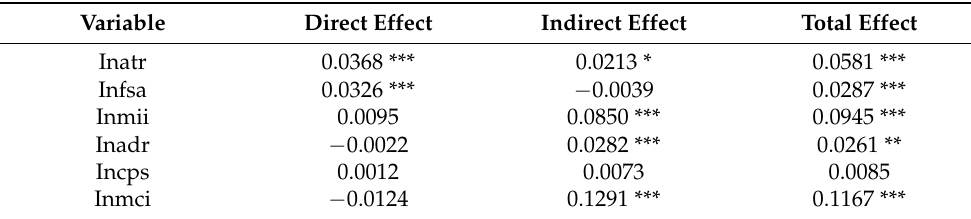
Table 12. Decomposition results of the spatial effect of agricultural technology R&D on agricultural green development under the economic